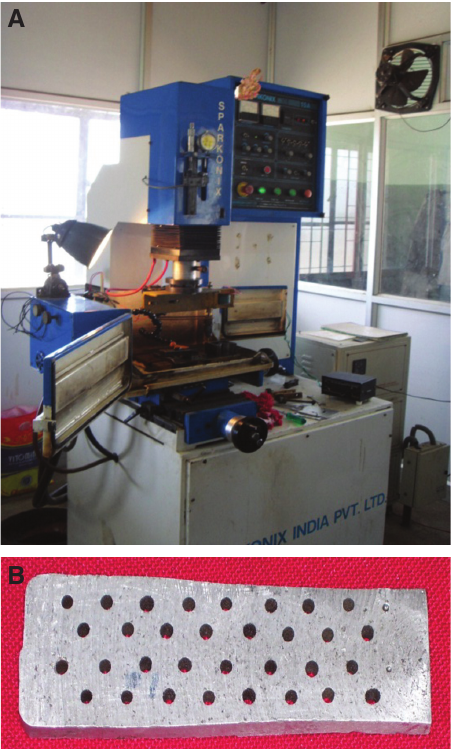
Figure 1 (A) Experimental setup. (B) Machined workpiece.